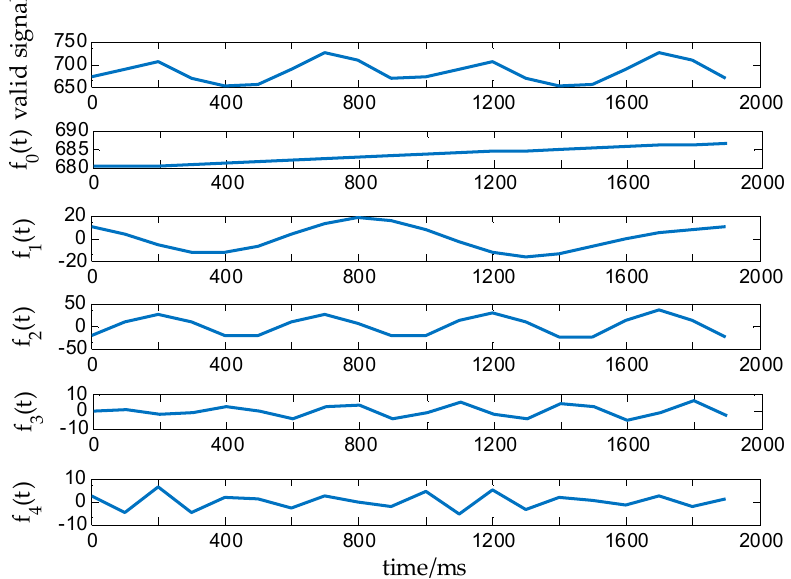
Figure 8. EWT decomposition diagram for a high-grade activity signal.